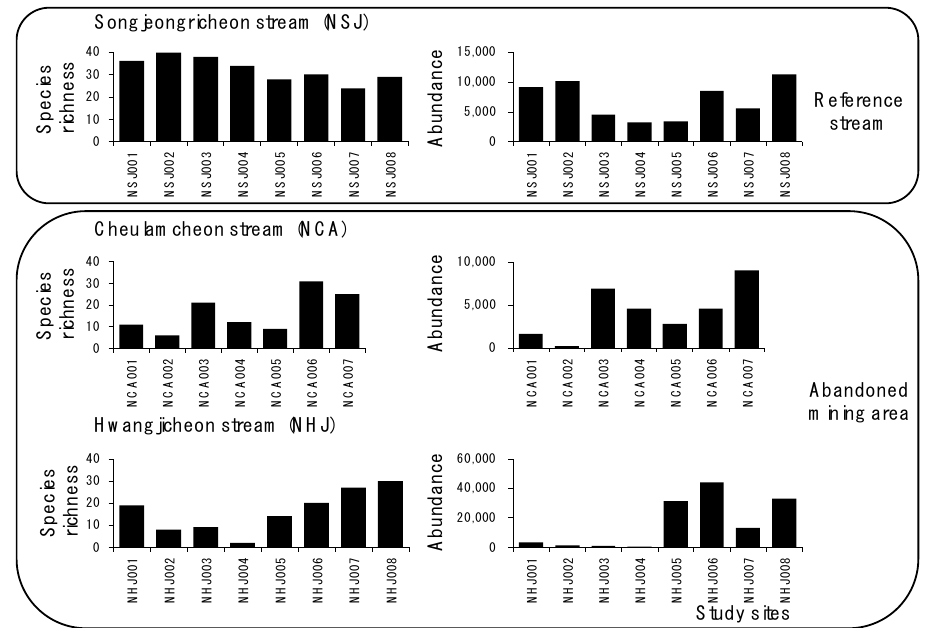
Figure 3. Differences in species richness and abundance in streams in the reference site (NSJ) and abandoned mining areas (NCA and NHJ).